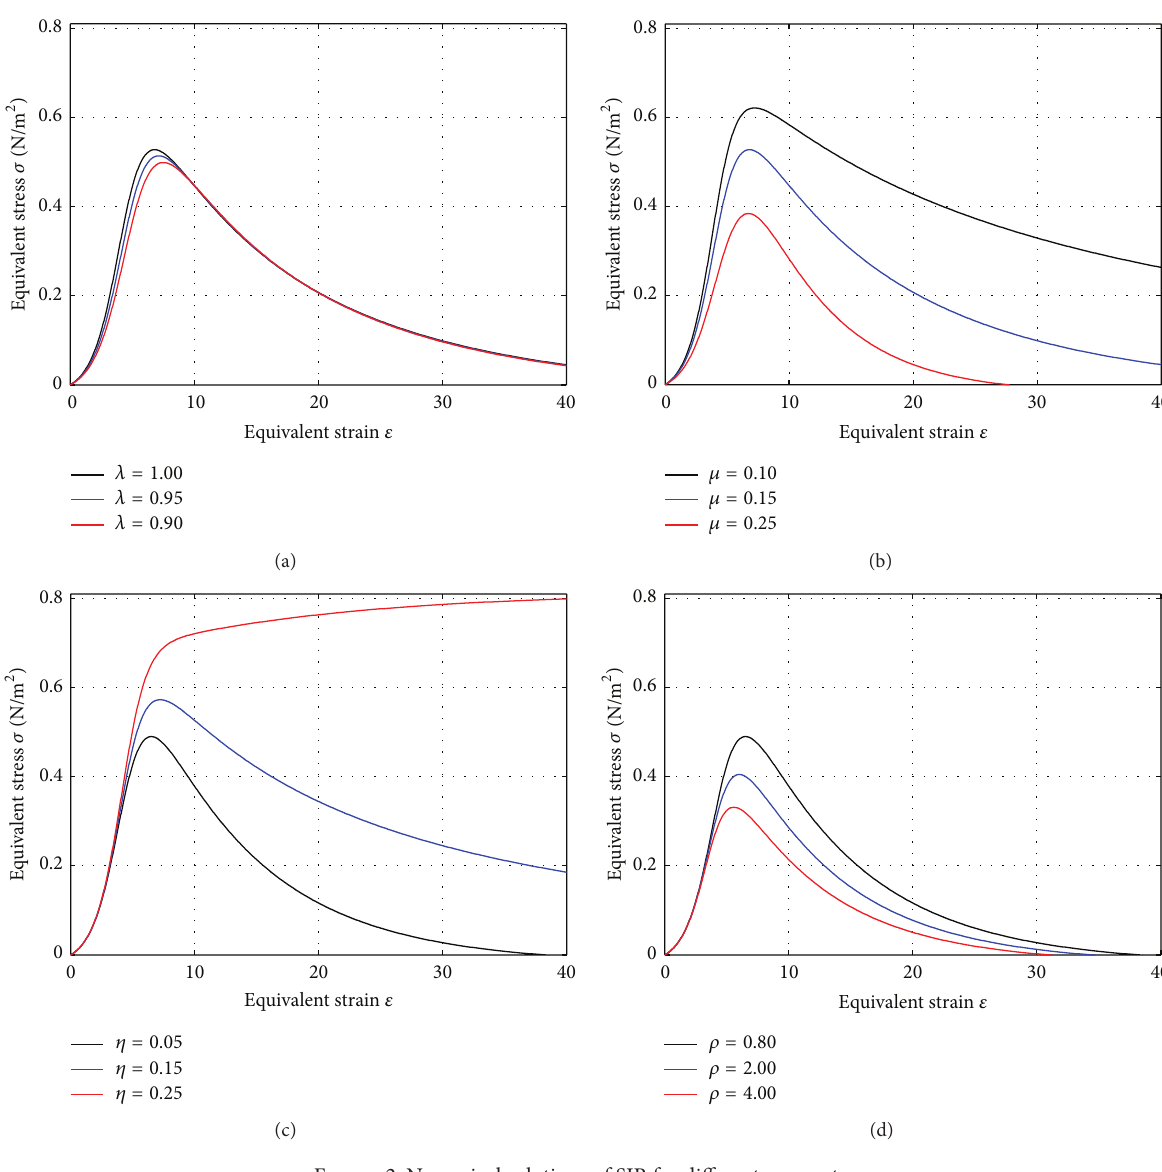
Figure 2: Numerical solutions of SIR for different